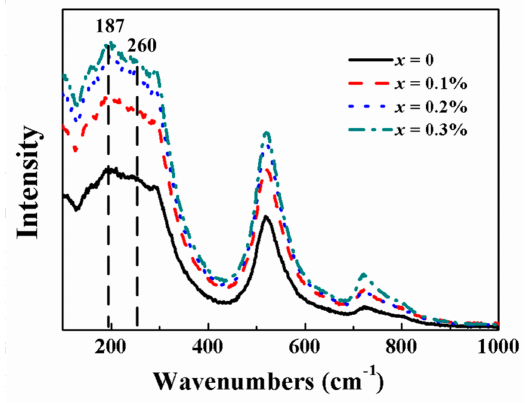
Figure 3. Raman spectra of the BZT-0.5BCT- x Pr 6 O 11 ceramics measured at room temperature under the 633-nm source